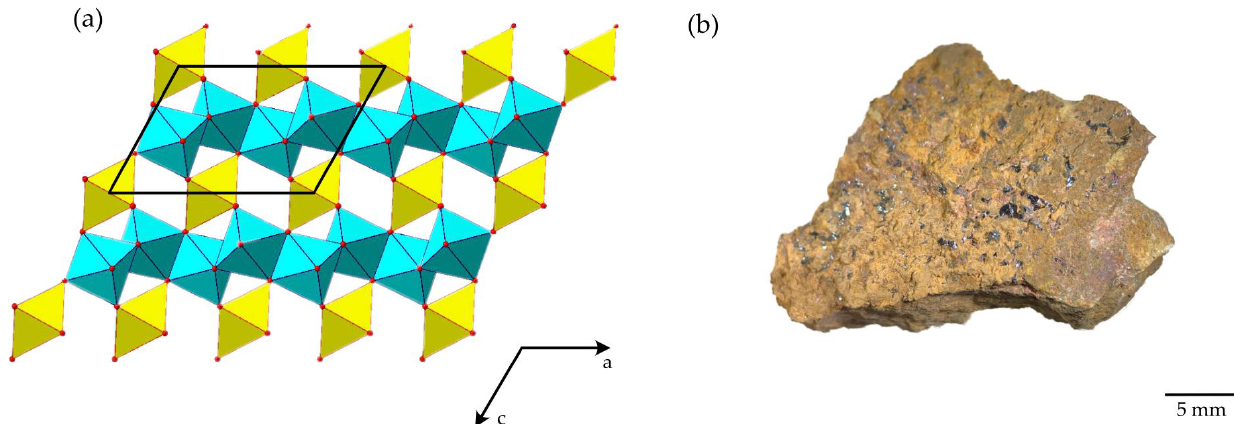
Figure 1. General projection of the crystal structure of brannerite along the b axis (UO 6 = yellow octahedra; TiO 6 = blue octahedra; structure drawing is based on data reported in Szymanski and Scott [2]) ( a ). Brannerite (black massive grains) in a host rock from Akchatau (Kazakhstan) ( b ).